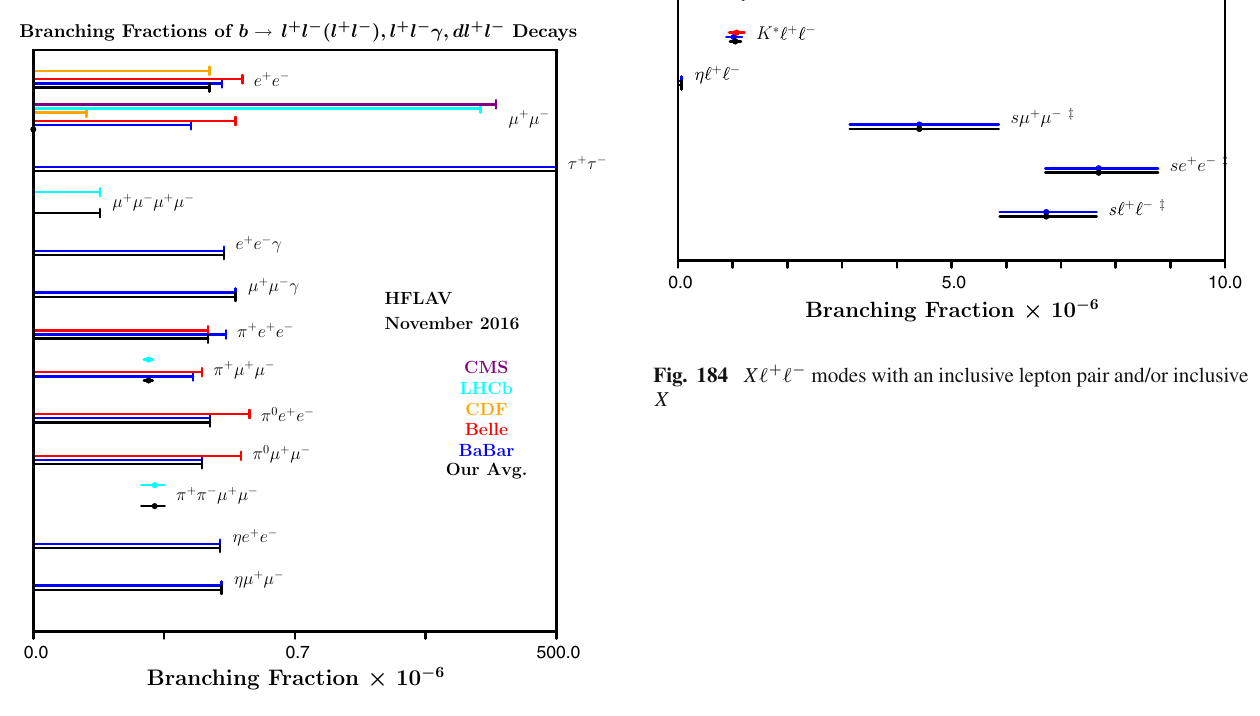
Fig. 183 Branching fractions of b → (cid:12) + (cid:12) − ((cid:12) + (cid:12) − ),(cid:12) + (cid:12) − γ and b → d (cid:12) + (cid:12) − decays